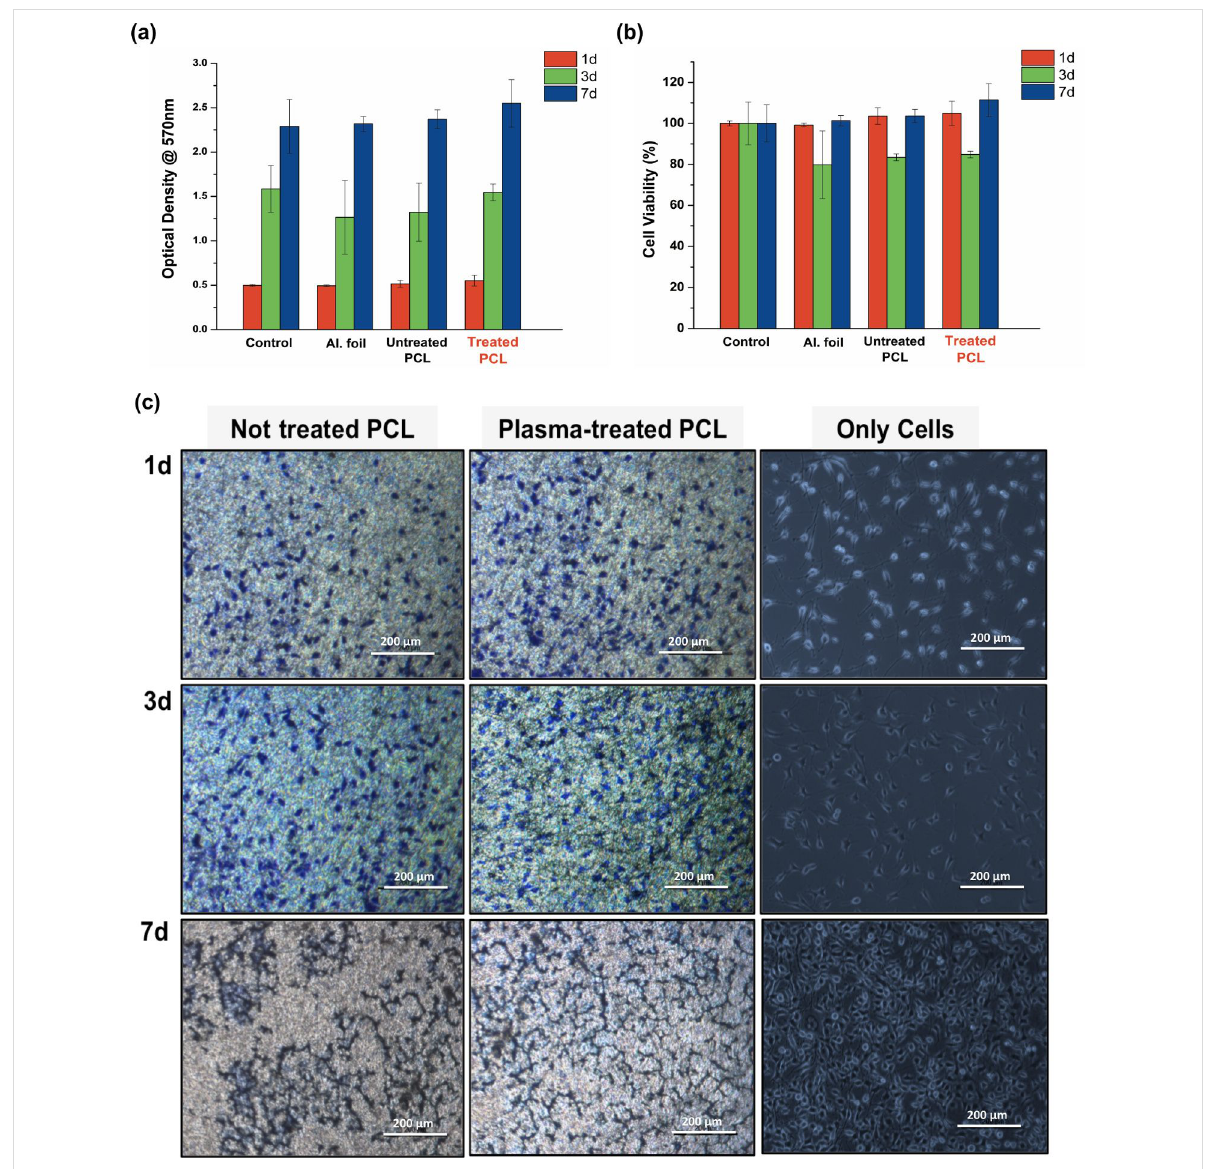
Figure 4: (a,b) MTT assay of L929 cells in direct contact with the examined systems after 1, 3 and 7 days, in terms of optical density values as well as the normalized % cell viability, respectively, and (c) optical imaging of the cell morphology in the predetermined time periods for the untreated and the plasma treated